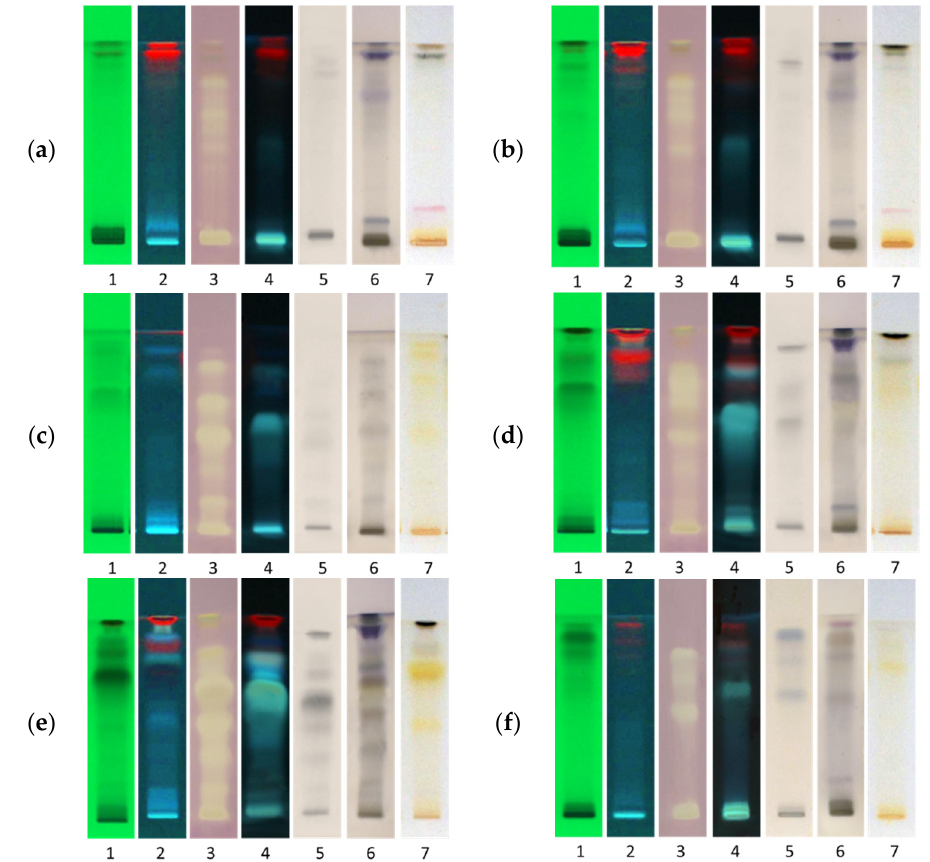
Figure 3. HPTLC fingerprints of ( a ) methanol extract, ( b ) ethanol extract, ( c ) fermented ethanol extracts ( d ) ethyl acetate extract, ( e ) fermented ethyl acetate extract, ( f ) Soxhlet ethanol extract. Track 1, UV 254 nm; track 2, UV 366 nm; track 3, DPPH • assay; track 4, with AlCl 3 under UV 366 nm; track 5, with ferric chloride; track 6, with anisaldehyde/sulfuric acid under white light; track 7, with phloroglucinol/hydrochloric acid under white light.